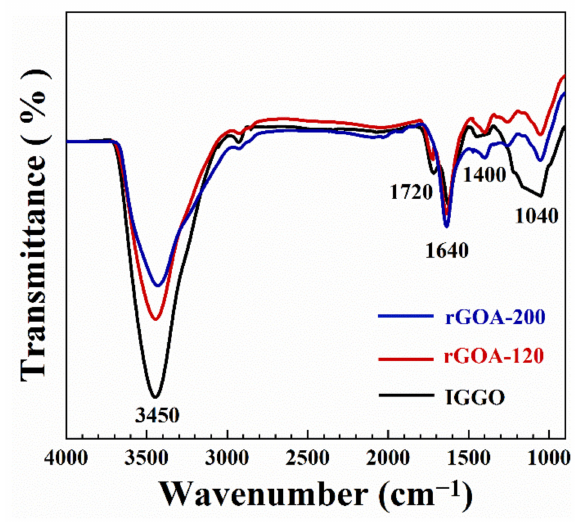
Figure 7. FTIR spectra of IGGO, rGOA-120 and rGOA-200.